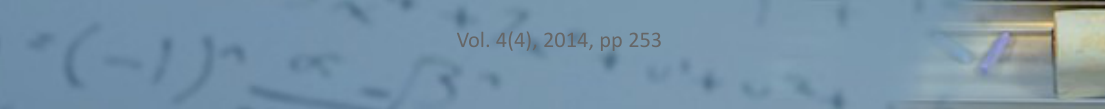
Figure 1. Survey about solving